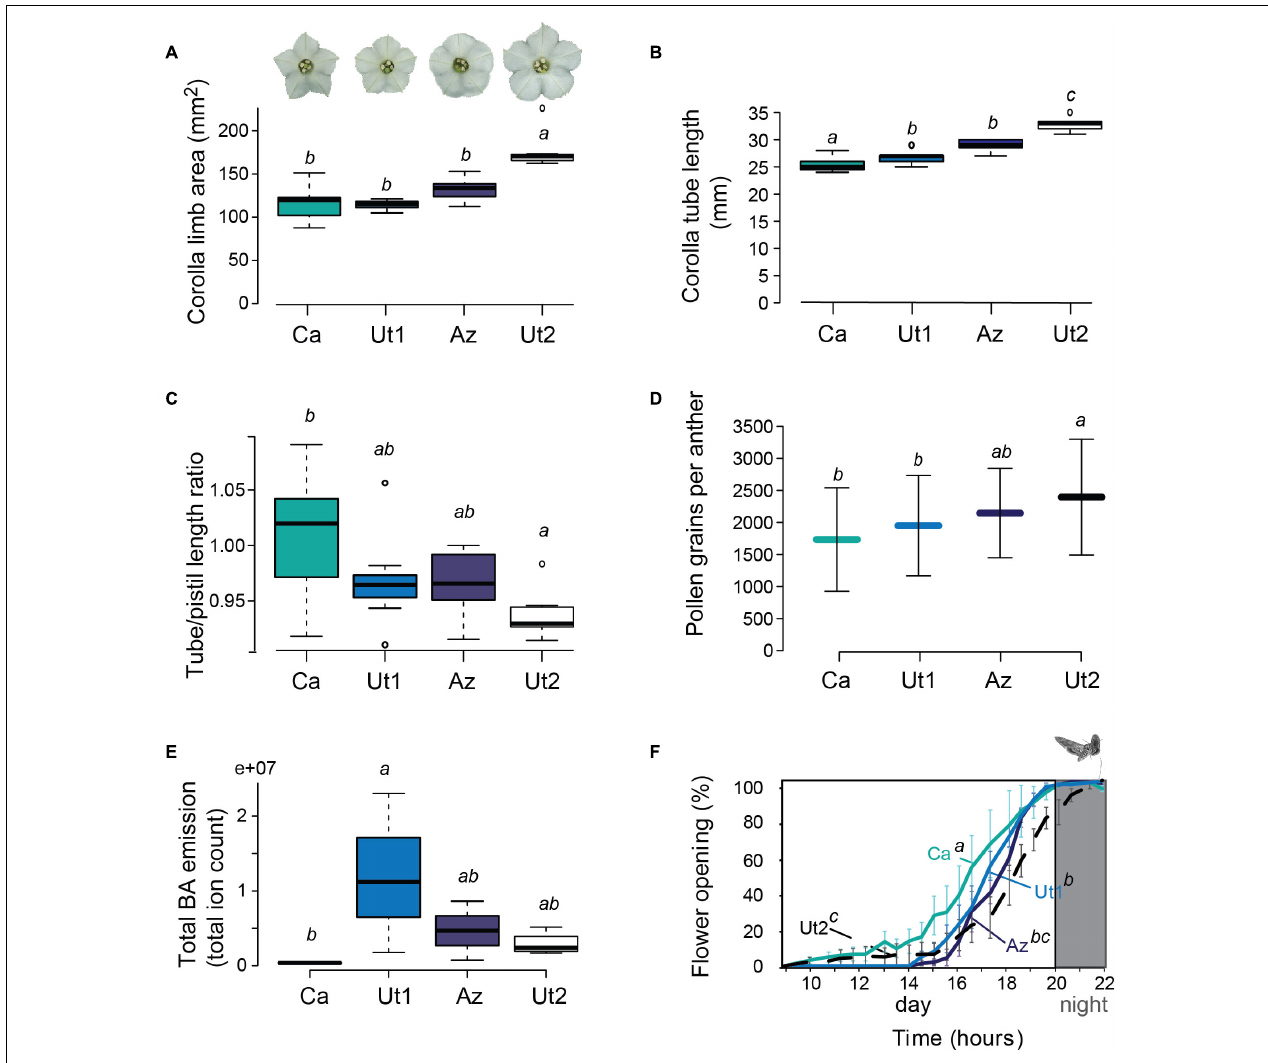
FIGURE 1 | Floral morphology and pollen number of four native Nicotiana attenuata accessions. (A) Boxplot showing the corolla limb area analyzed using the R package “Momocs” [ N = 7, generalized linear model followed by post hoc Tukey with Holm adjustment, different letters indicate significant differences ( p < 0.001)]. (B) Boxplot of corolla tube length [ N = 7, ANOVA model followed by HSD test with Holm adjustment, different letters indicate significant differences ( p < 0.005)]. (C) Boxplot showing the corolla tube/pistil length ratio. Values above 1 indicate a stigma which is shorter than the corolla tube, whereas a value below 1 indicates a stigma located outside of the corolla tube [ N = 7, generalized linear model followed by pairwise Wilcoxon test with Holm adjustment, different letters indicate significant differences ( p < 0.05)]. (D) Number of pollen grains (mean ± SD) per anther [ N = 45, ANOVA followed by HSD test, different letters indicate significant differences ( p < 0.05)]. (E) Boxplot showing the total BA emission of flowers [ N = 4, generalized linear model followed by HSD test, different letters indicate significant differences ( p < 0.05)]. (F) Flower opening (mean ± SEM) between 9 and 22 h [ N = 4, generalized linear model followed by HSD test with Holm adjustment, different letters indicate significant differences ( p < 0.05)]. The flower opening refers to the flower aperture measured in millimeters and expressed as percentage of opening. The gray bar represents the activity period of M. sexta within the time span measured. Boxplots show the median (thick bar), the first and the third quartiles [box and 1.5 times the interquartile range (whiskers)]. Abbreviations for accessions: Az, Arizona; Ca, California; Ut1, Utah 1; Ut2, Utah